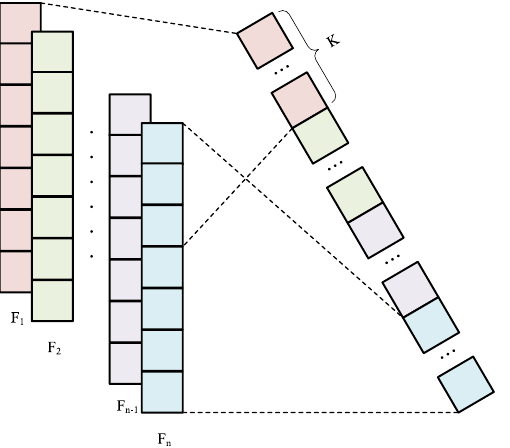
Figure 4. K-MaxPooling schematic